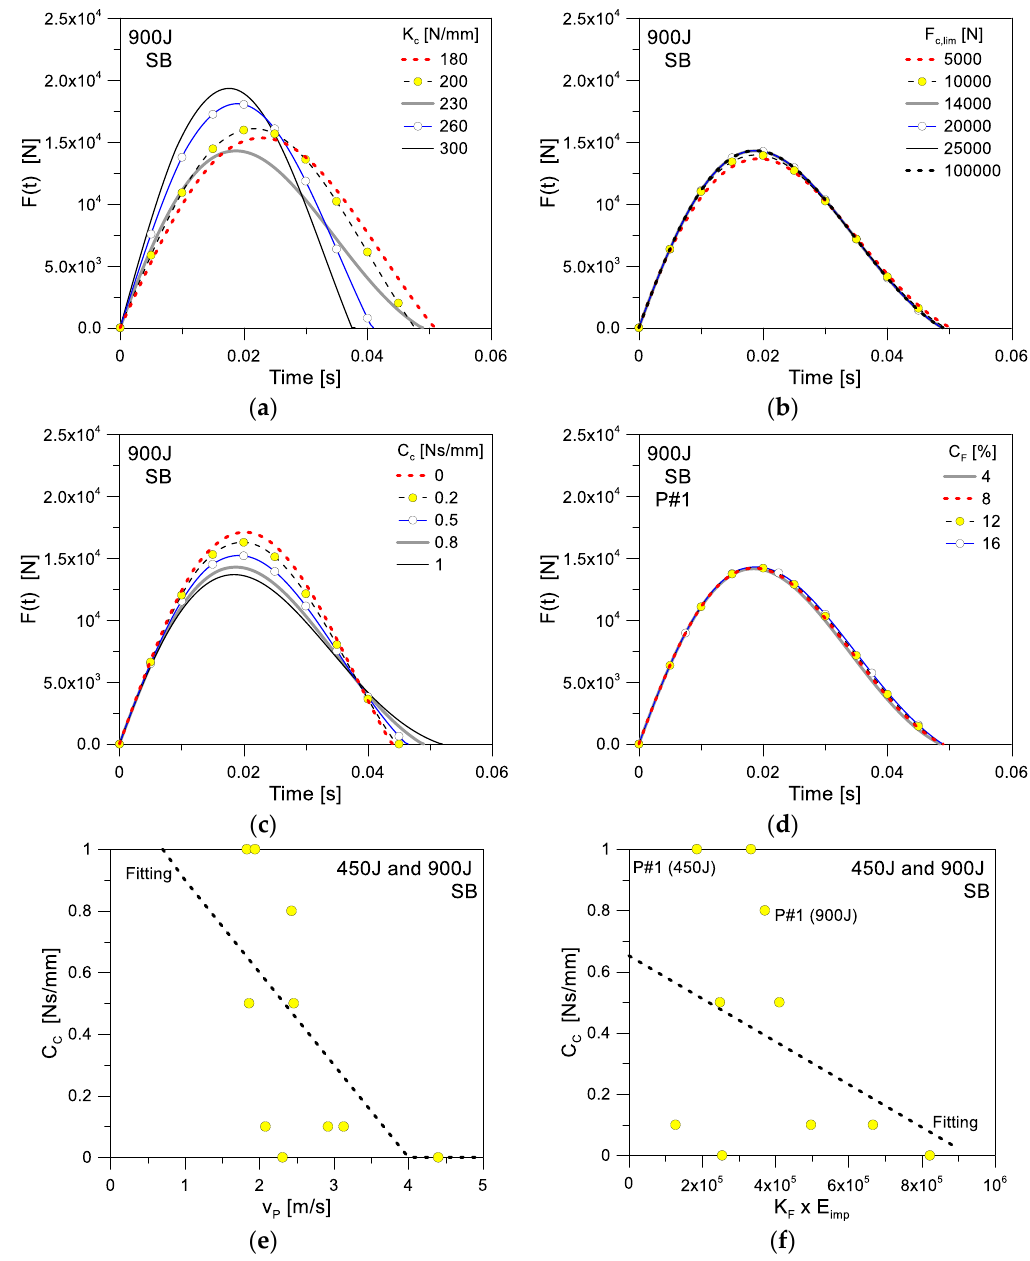
Figure 20. Sensitivity analysis of the 2-DOF impact time histories to selected input parameters: ( a ) contact stiffness, ( b ) contact limit force, ( c ) contact damping and ( d ) facade damping, with ( e , f ) variation of contact damping with impactor velocity, facade stiffness and impact energy.